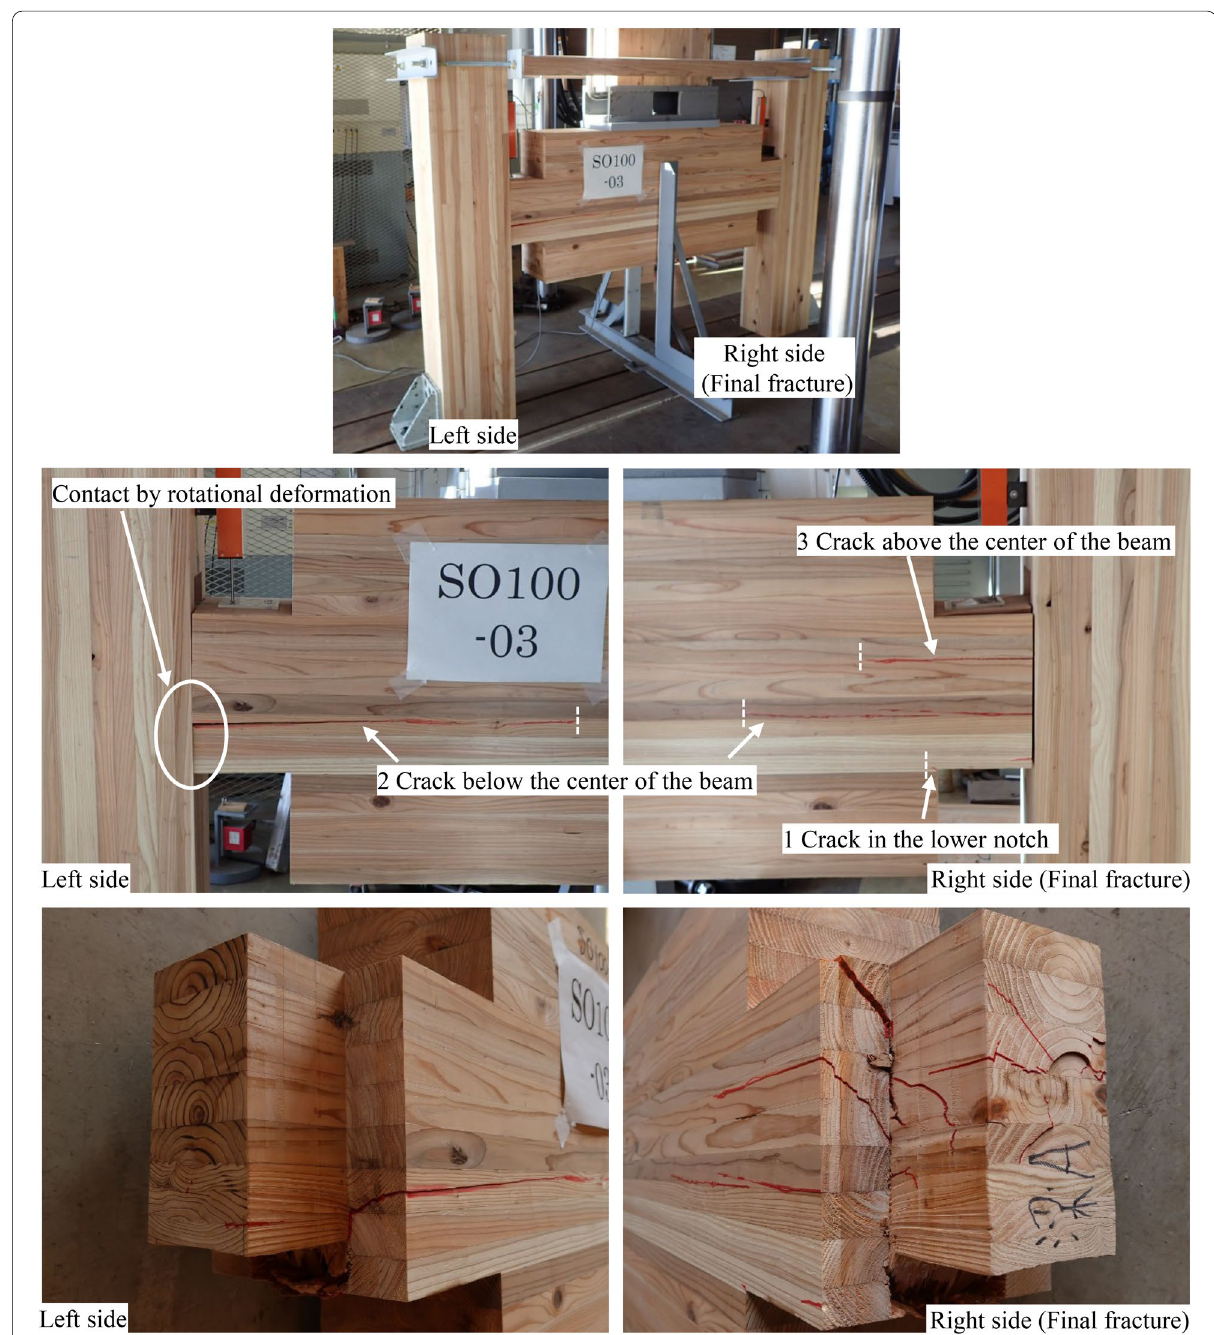
Fig. 12 Final fracture state of the specimen (J-L100, No.